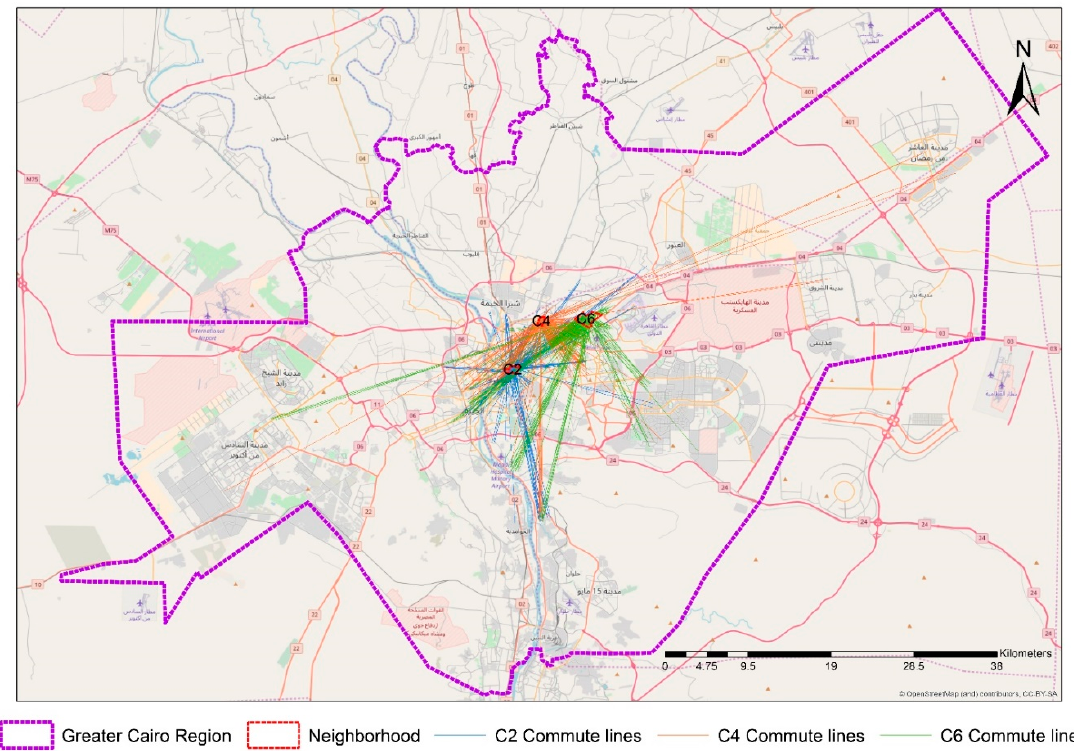
Figure 1. Illustration of linear commute distances in 18 neighborhoods in Tehran (top), Istanbul (middle), and Cairo (bottom) illustrated by aerial lines.